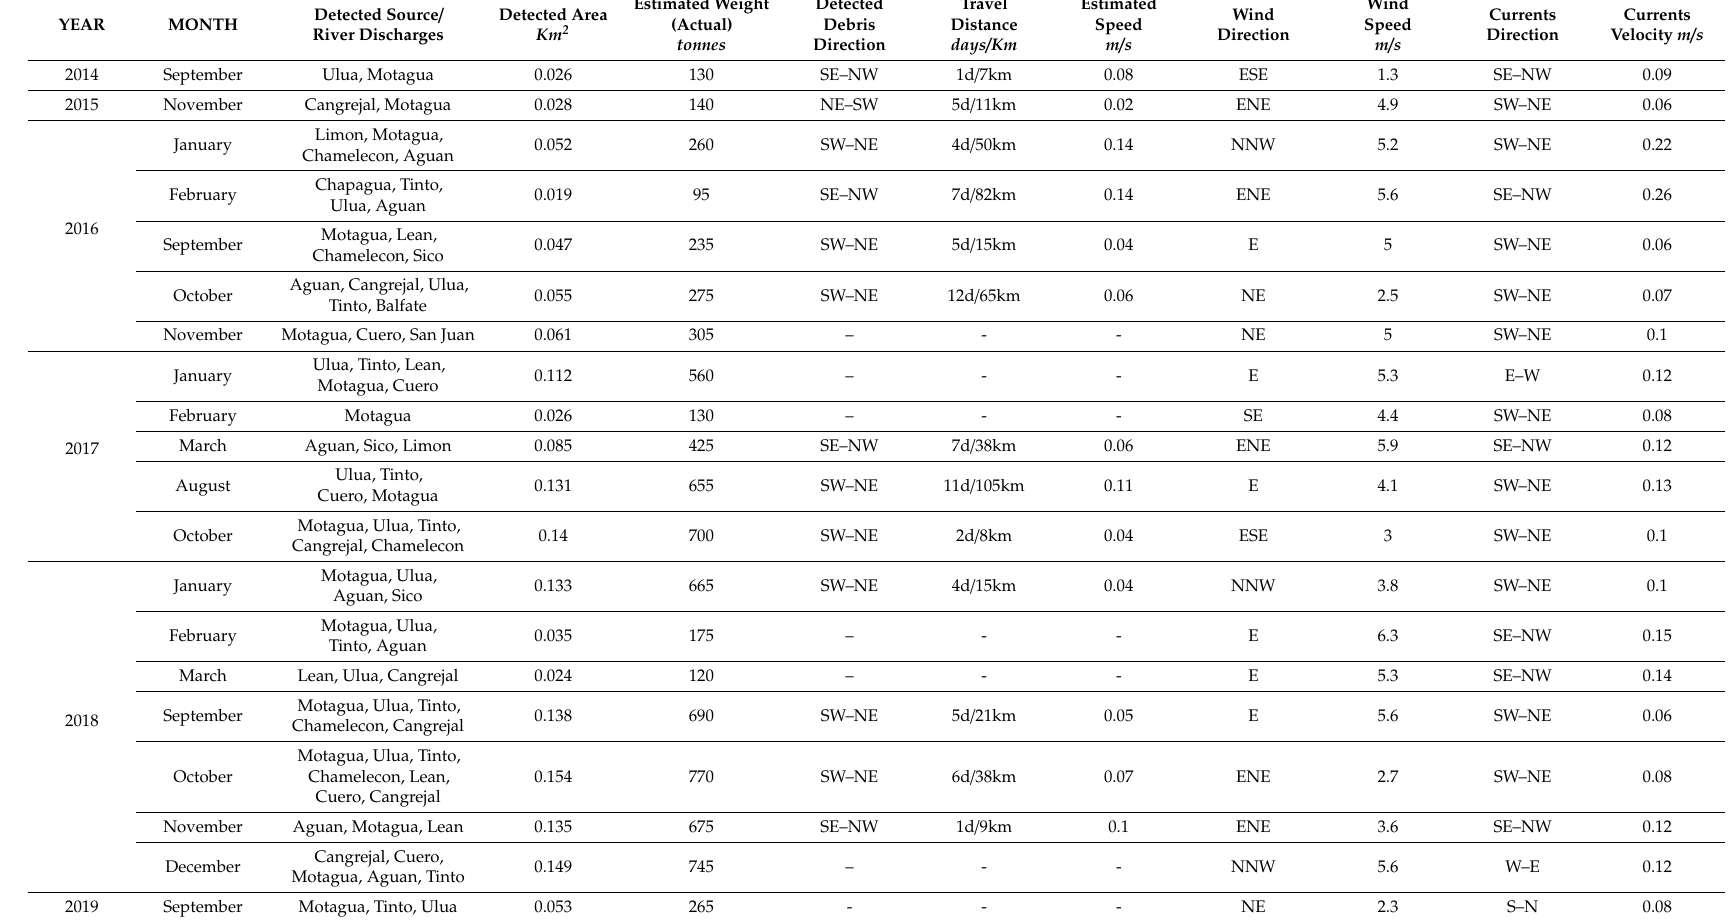
Table 2. The detected 20 plastic debris events in Bay Islands for the years 2014 to 2019. The detected area, weight, sources, travelling trajectories, wind and currents conditions are also presented for each